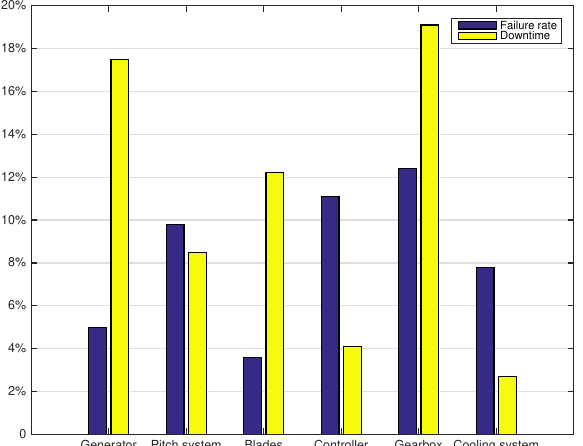
Figure 1. Normalized failure rates and downtimes of a wind